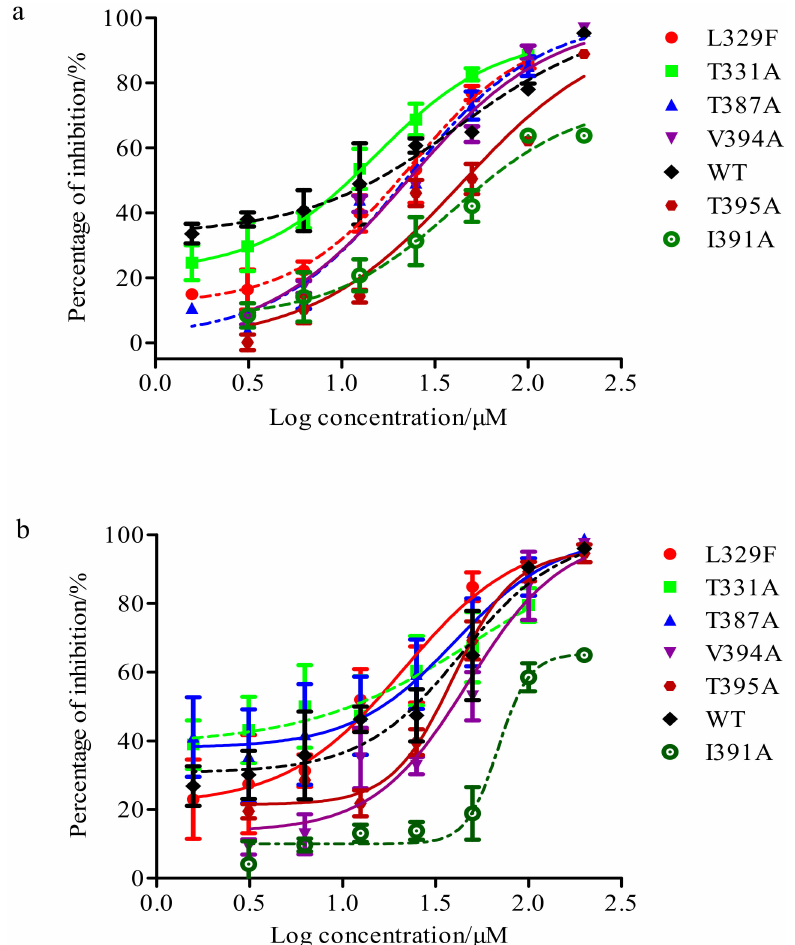
Figure 10. Inhibition rate curves of compounds against H5N1 pseudoviruses. ( a , b ) represent the dose–response curves of XC-27-1, XC-27-2 against wildtype and mutant H5N1 pseudovirus strains, respectively. The error bars represent mean ± standard deviation (three replicates). The horizontal axis represents the log concentration of the derivatives, and the vertical axis represents the inhibition